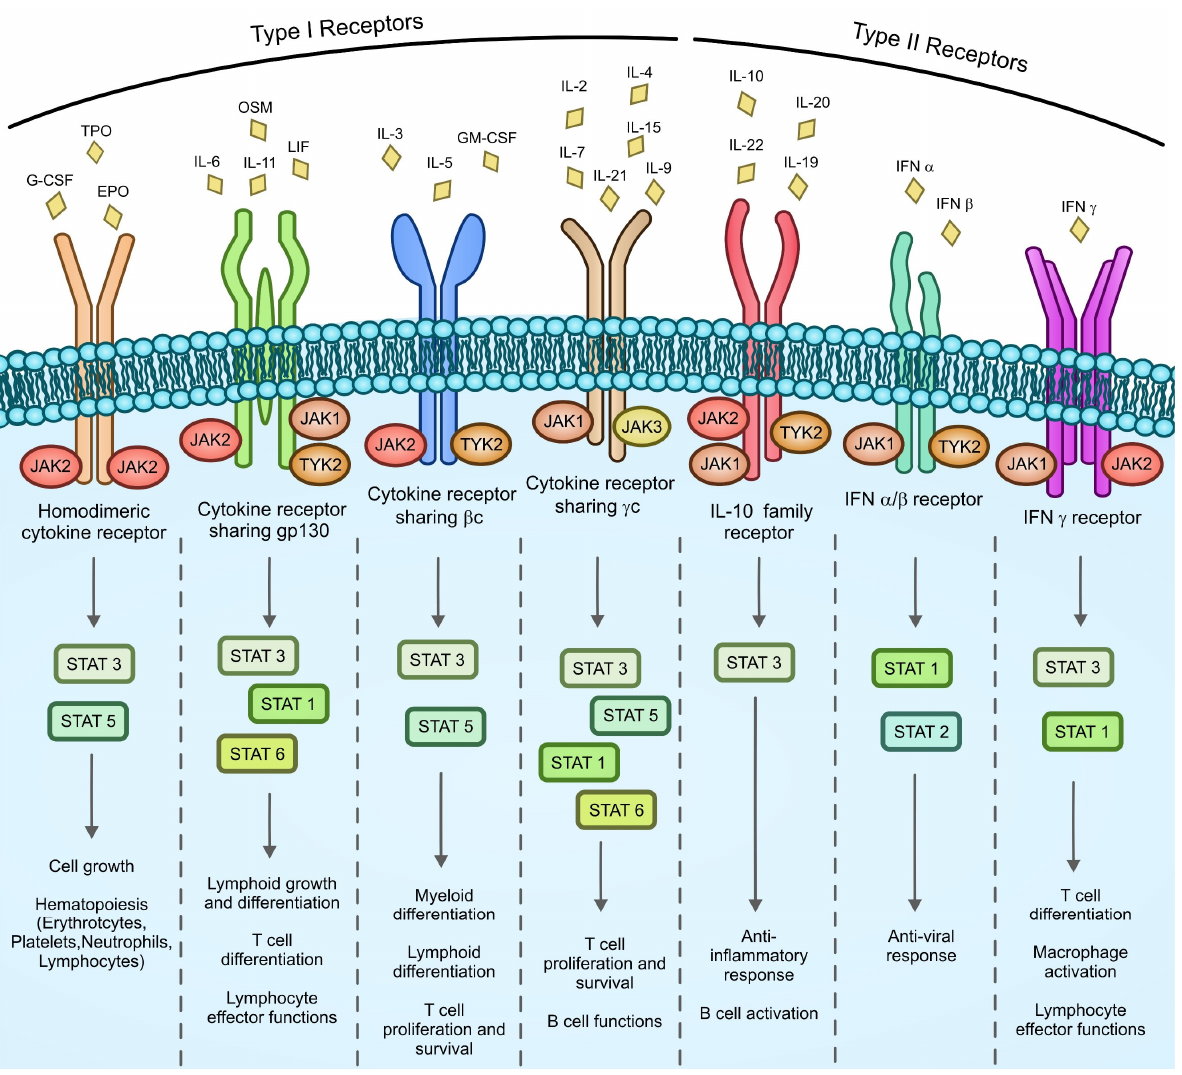
Figure 1. Cytokine receptor signaling in hematopoietic cells. More than 50 different cytokines are coded by the human genome. Cytokine receptors are particularly important in maintaining hema ‐ topoietic cell physiological functions. They are divided into two subfamilies (type I and type II re ‐ ceptors) based on the structure of the extracellular domain. In response to cytokine recognition, each receptor can bind different combinations of JAKs that, in turn, besides activating the MAPK and PI3K/AKT pathways (see Figure 2), may phosphorylate different STATs. EPO, erythropoietin; G ‐ CSF, granulocyte colony ‐ stimulating factor; GM ‐ CSF, granulocyte–macrophage colony ‐ stimulating factor; IFN, interferon; LIF, leukemia inhibitory factor; OSM, oncostatin M; TPO, thrombopoietin. In physiological conditions, JAK2 proteins, which are stably bound to the cytoplas ‐ mic region of several type I and II receptors [54], get activated in response to ligand bind ‐ ing and promote their own phosphorylation and the phosphorylation of tyrosine residues in the cytoplasmic region of the receptor. STATs bind through their SH2 domains to these phosphorylated tyrosines and get phosphorylated by JAKs. Phosphorylated STATs de ‐ tach from the receptor, dimerize, translocate into the nucleus and activate the transcrip ‐ tions of target genes (Figure 2).